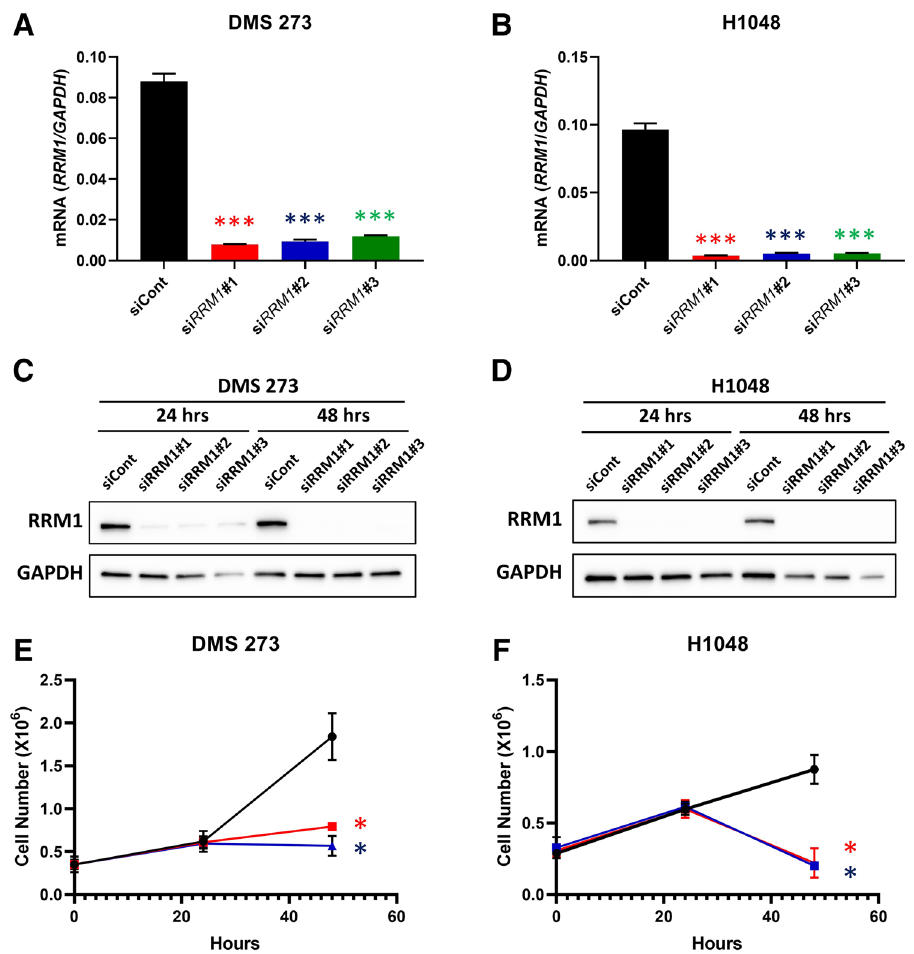
Figure 2. RRM1 knockdown in SCLC cell lines. ( A ) and ( B ), effect of RRM1 -siRNA on RRM1 mRNA levels. RRM1 -specific siRNAs (si RRM1 #1: red, si RRM1 #2: blue, si RRM1 #3: green, siCont: black) were used to knock down RRM1 in SCLC cells. RRM1 expression was normalized to that of GAPDH . Data represent the mean ± standard deviation (SD; n = 3). P values are indicated as ***, < 0.005, Dunnett’s multiple comparisons test. ( C ) and ( D ), effect of RRM1 -siRNA on RRM1 protein levels. Western blot analysis of si RRM1 ‐ treated SCLC cells with GAPDH as the loading control. The blots were cropped; full-length blots are included in the Supplementary Information. ( E ) and ( F ), cell growth inhibition measured using the proliferation assay. siCont: black, si RRM1 #1: red, si RRM1 #3: blue. Data represent the mean ± SD ( n = 6–10). * p < 0.05 vs. control, Dunnett’s multiple comparisons